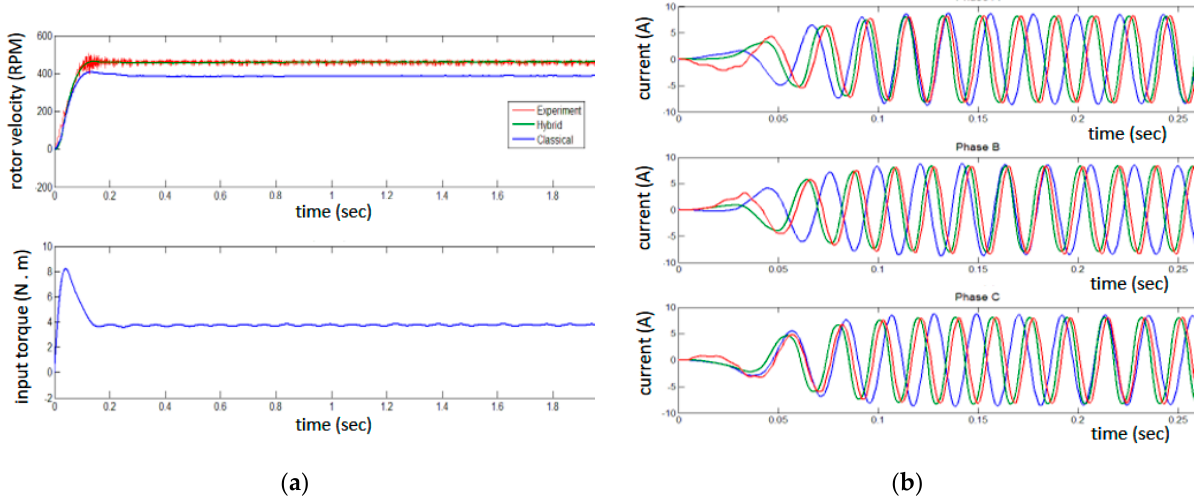
Figure 8. Full speed transient response, showing ( a ) the rotor velocity and input torque and ( b ) a comparison of the stator currents. The plots show a comparison of the classical model (blue trace), hybrid model (green) and experimental measurements (red).